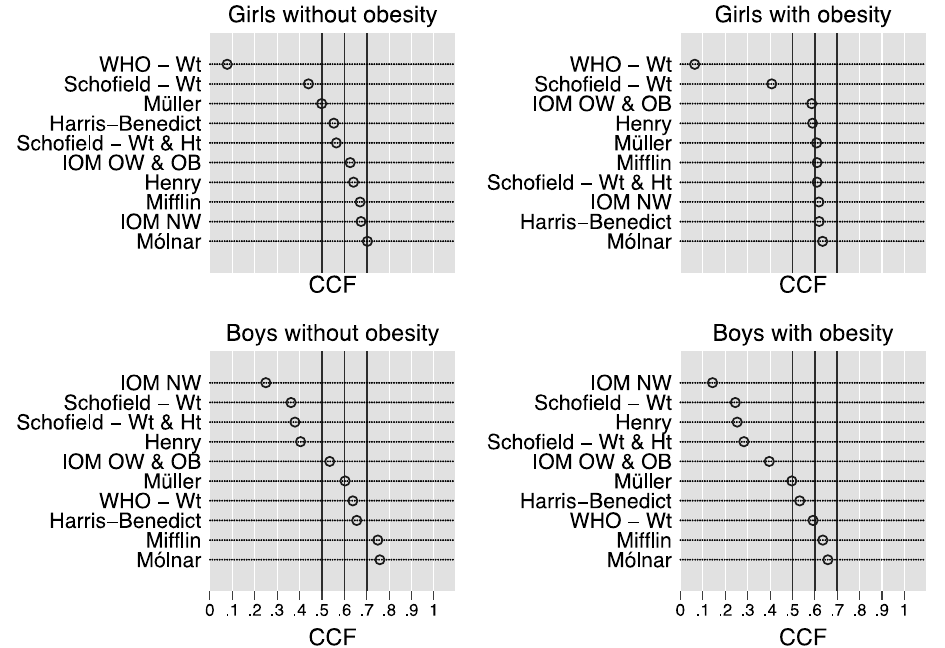
Figure 2. Correct classification fraction of the REE prediction equations. Dot charts showing the correct classification fraction of the REE prediction equations in the 2426 children stratified by sex and obesity. The correct classification fraction of an equation is defined as the fraction of subjects whose estimated resting energy expenditure is within 10% of measured resting energy expenditure and varies from 0 (0%) to 1 (100%). Abbreviations: WHO = World Health Organization; Wt = weight; Ht = height; IOM = Institute of Medicine; NW = (equation for) children with normal weight; OW = (equation for) children with overweight; OB = (equation for) children with obesity.